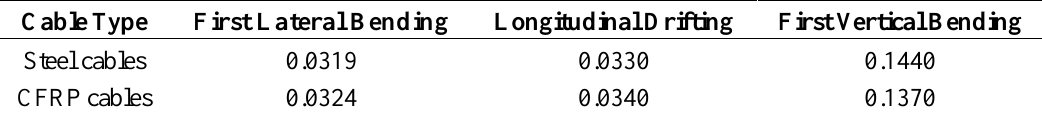
Table 7. Major natural frequencies of cable-stayed bridge (units: